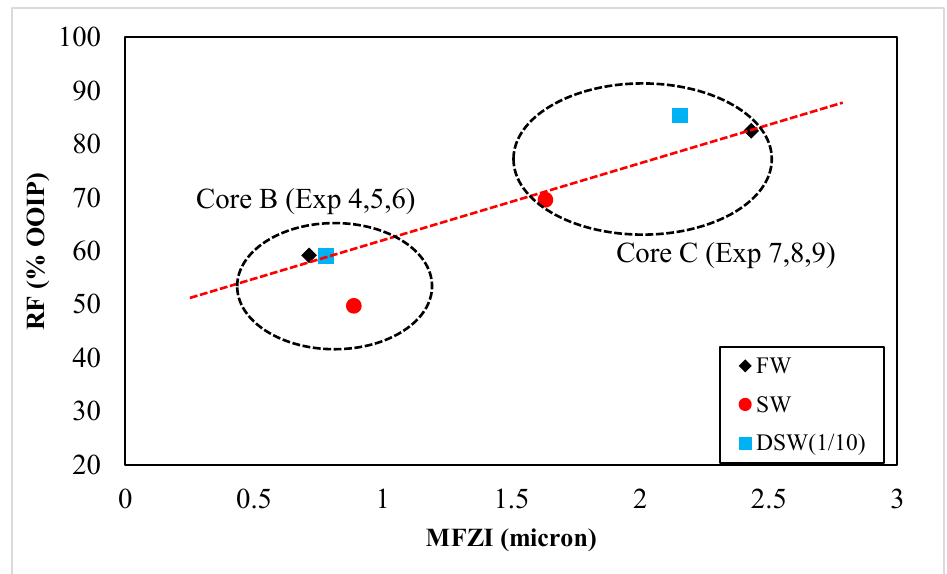
Figure 9. Correlation between MFZI and secondary recovery factor.